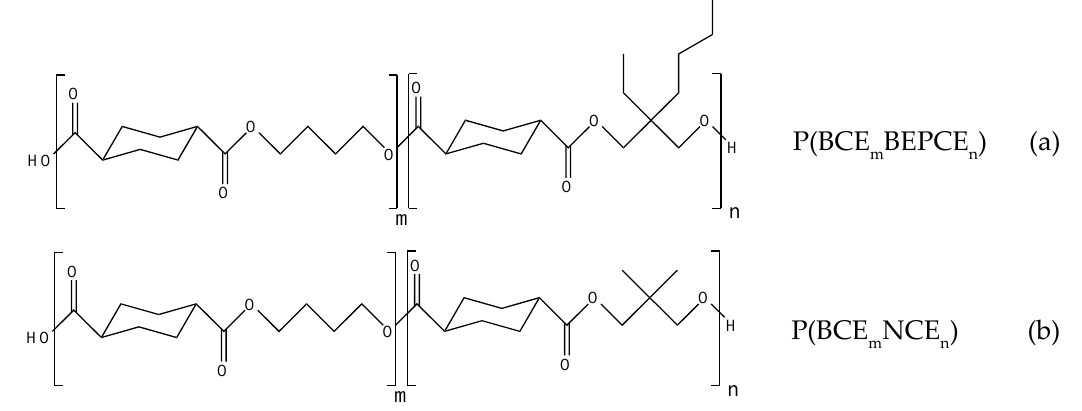
Figure 1. Chemical structures of P(BCE m BEPCE n ) ( a ) and P(BCE m NCE n ) ( b ) random copolymers.